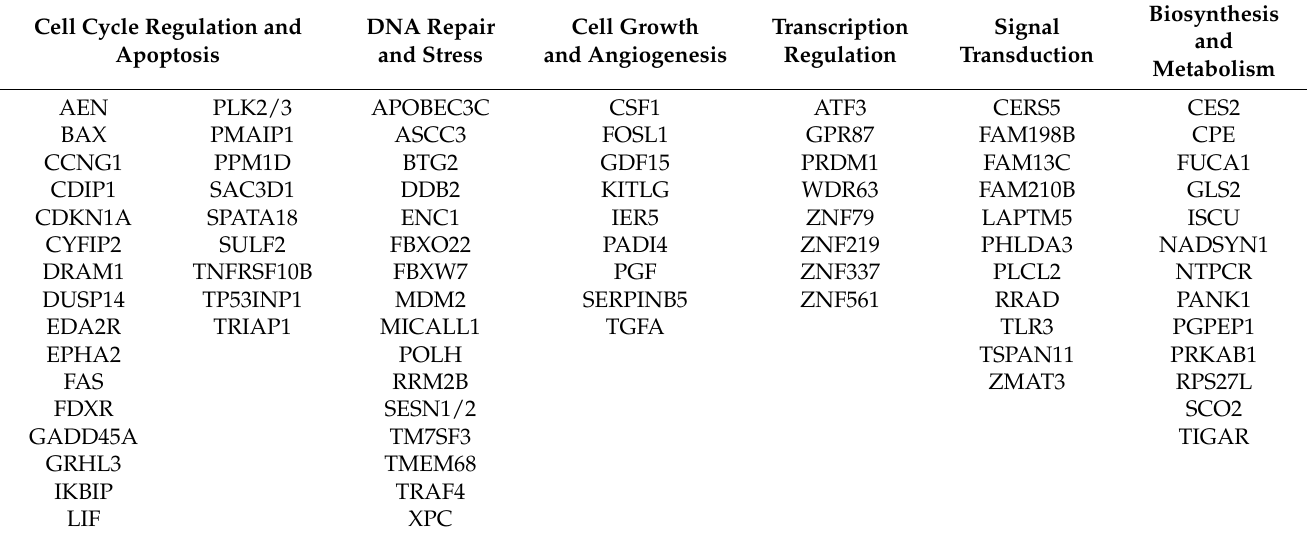
Table 1. Examples of transcriptionally activated target genes of p53 and their